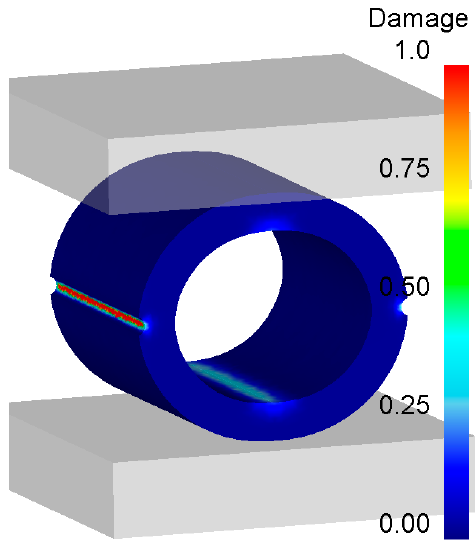
Metals 2019 , 9 , x FOR PEER REVIEW Figure 32. Simulation model of compression of a notched ring. Figure 32. Simulation model of compression of a notched ring.